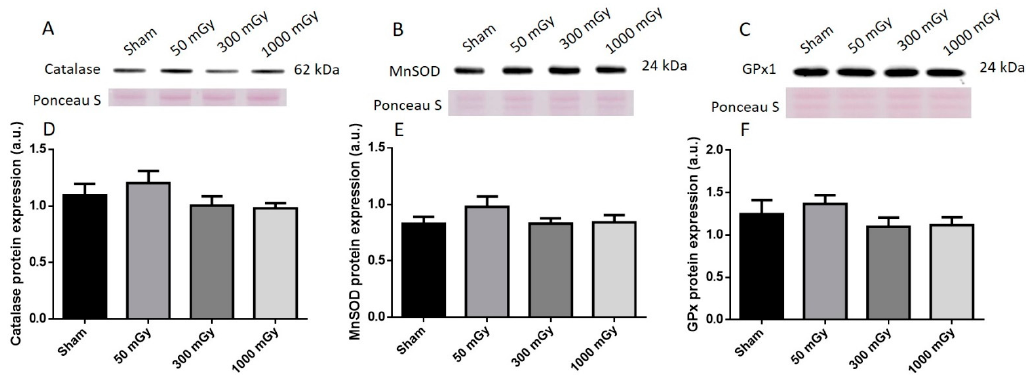
Figure 10. Representative western blot ( A – C ) and quantified band density ( D – F ) (relative protein expression in arbitrary units) for ( A ) catalase, ( B ) manganese superoxide dismutase (MnSOD), and ( C ) glutathione peroxidase 1 (GPx1) in female offspring cardiac tissues. Results were normalized to loading controls (samples repeated on each gel) to account for differences between gels, and Ponceau S staining was used as a marker of equal protein loading. Data are presented as a mean ± SEM. n = 11–19 per group.